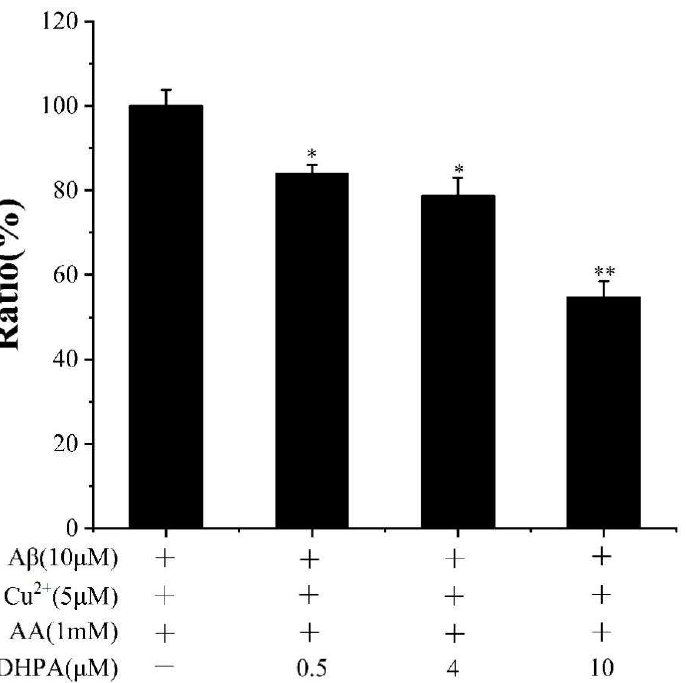
Figure 3. CCA fluorescence ratio of A β (1–42) /Cu 2+ /AA solutions in the absence or presence of different concentrations of DHPA. * p < 0.05 and ** p < 0.01 compared to values obtained in the A β (1–42) /Cu 2+ /AA solution.